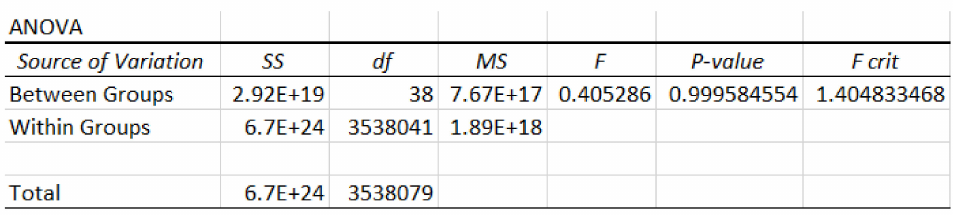
Figure 10. ANOVA test